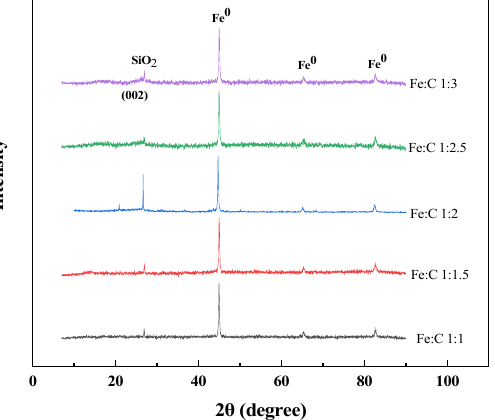
Figure 6. XRD pa tt erns of fi llers with di ff erent ratios.